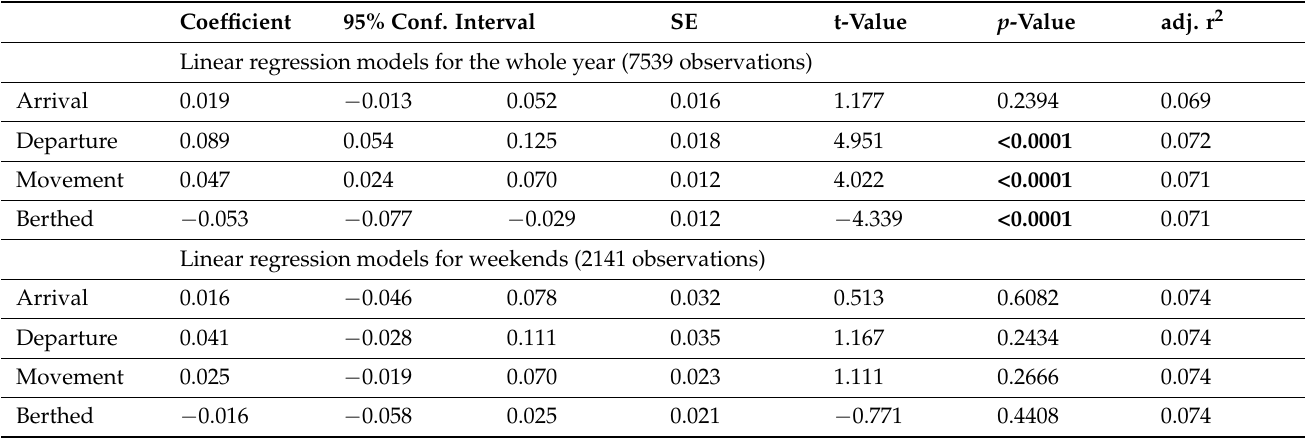
Table 11. Multivariable linear regression analysis results for vessel arrivals, departures, movement and laying alongside to the logarithm of PM 2.5 hourly mean concentrations controlled for wind direction, relative humidity and air temperature at West Harbour in 2020. p -values less than 0.05 in